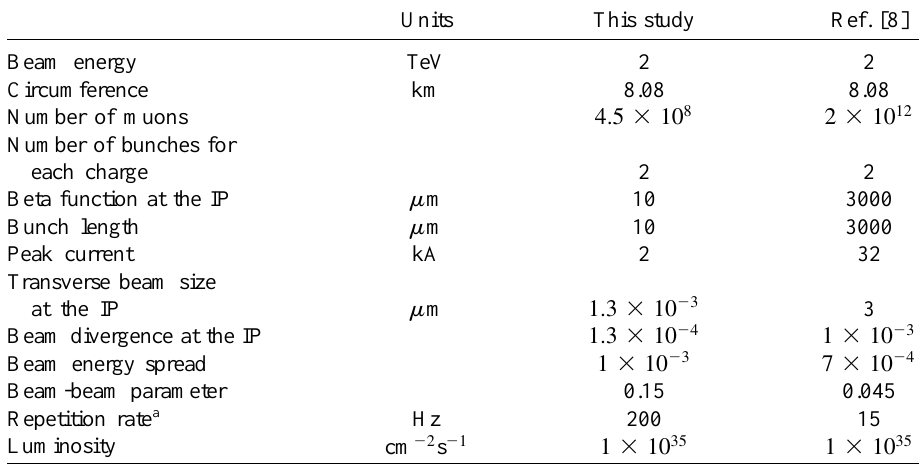
TABLE II. List of the parameters for a 2 TeV 3 2 TeV muon